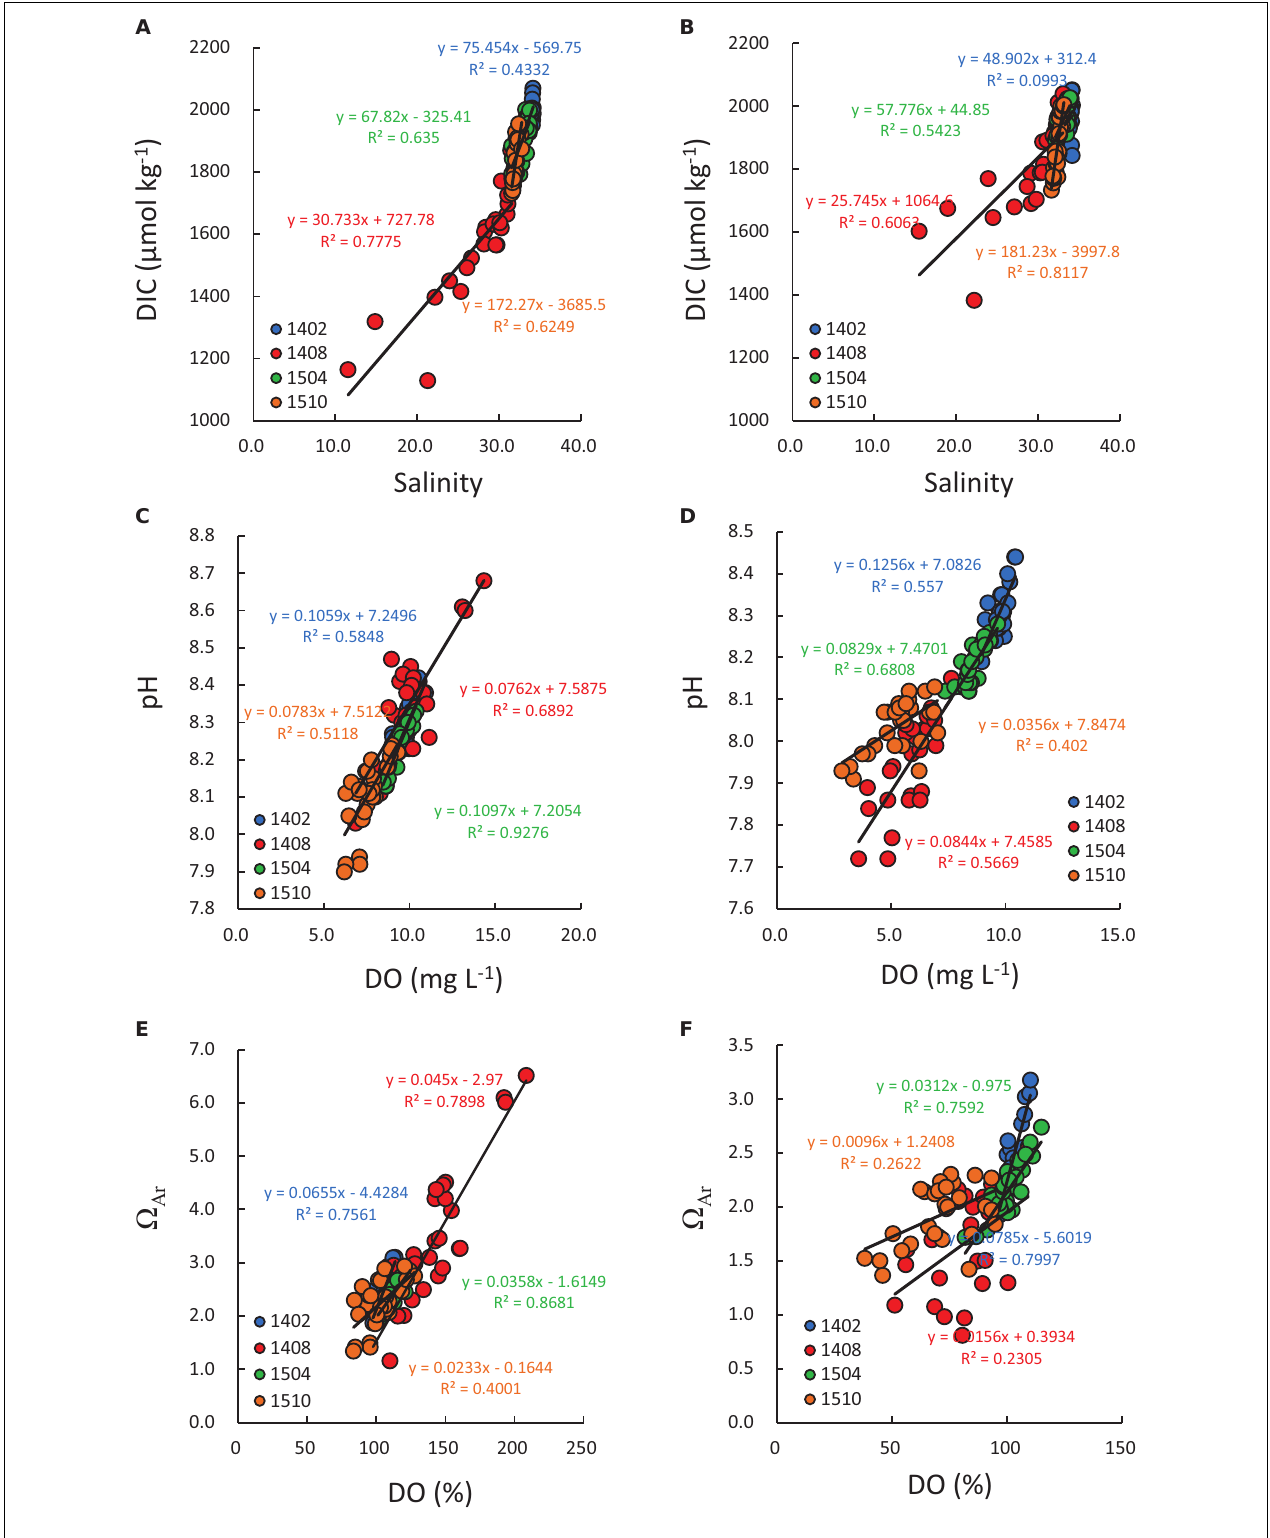
FIGURE 11 | Plots of salinity versus DIC in surface water (A) and bottom water (B) , dissolved oxygen (DO) versus pH in surface (C) and bottom (D) water, and DO (%) versus (cid:127) Ar surface (E) and bottom (F) water for each survey (dots: blue, Feb. 2014; red, Aug. 2014; green, Apr. 2015; dark yellow, Oct.